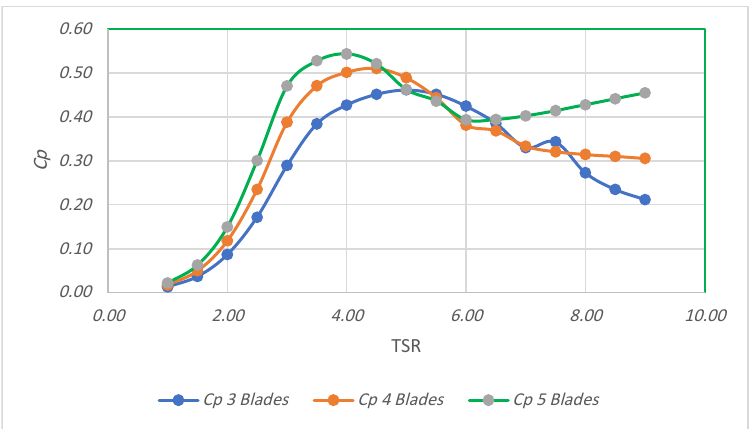
Figure 9. Coefficient of performance ( Cp ) vs. tip speed ratio (TSR) for 3, 4 and, 5 blades of VAWT.